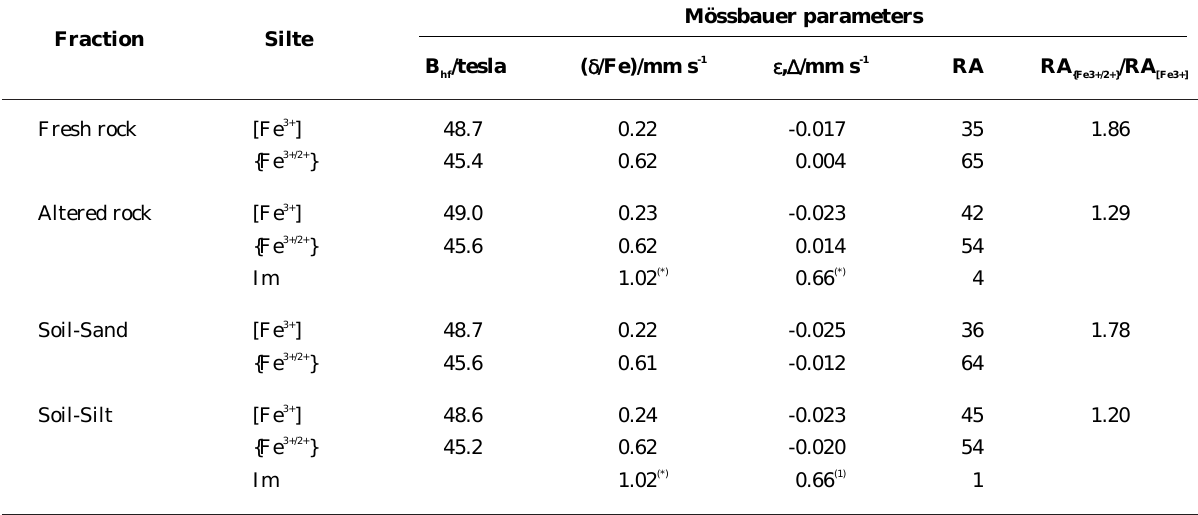
Table 4. Room temperature Mössbauer parameters of the 7xCBD treated